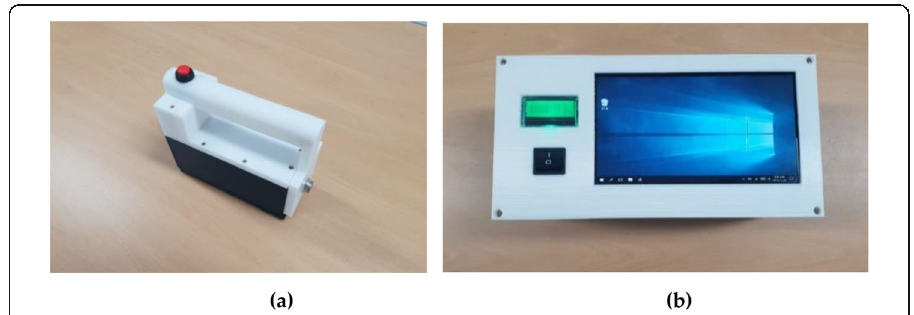
Fig. 1 The main body of the impact echo device and touch screen